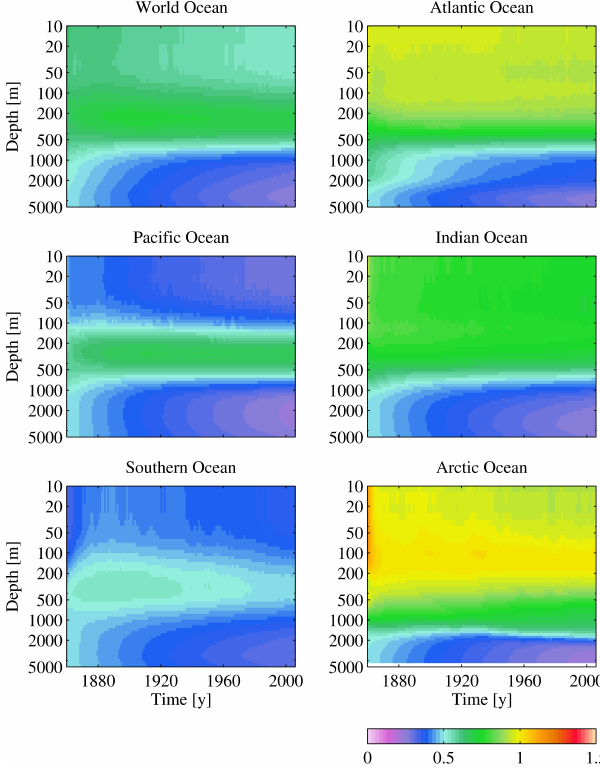
Fig.33. SimulatedverticalprofilesofironconcentrationaveragedfortheWorldOcean( topleft )and5majorregions. Fig. 39. Simulated vertical profiles of iron concentration averaged Concentrationsin µ molFem − 3 . Notethatdepthisshownonalogarithmicscale. for the World Ocean (top left) and 5 major regions. Concentrations in µmolFem − 3 . Note that depth is shown on a logarithmic scale.